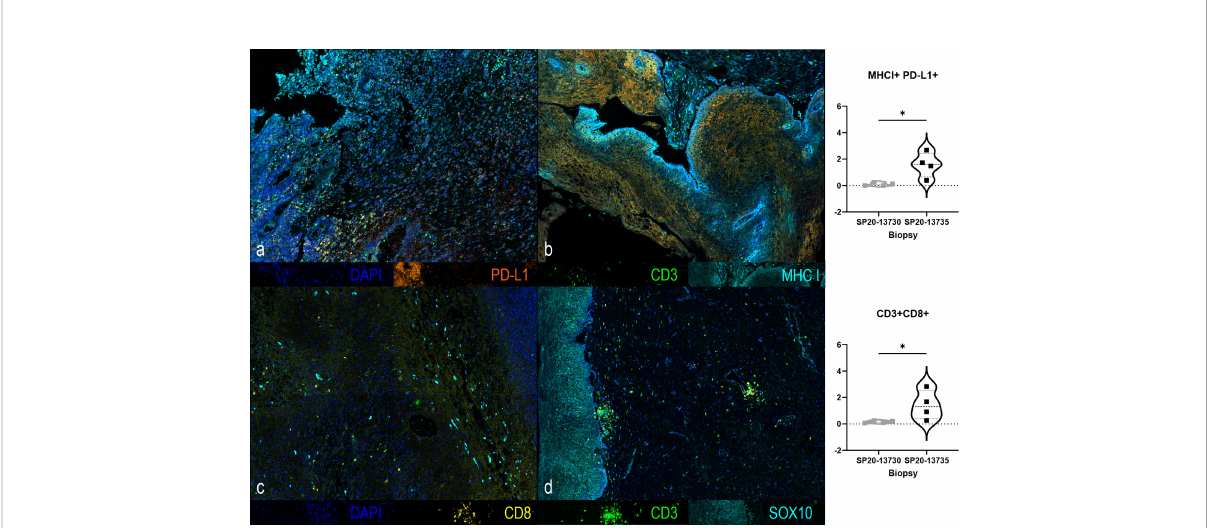
FIGURE 3 Multiplex immuno fl uorescence immunohistochemistry of tumor biopsies at baseline (A, C) and at 3 months (B, D) following the initiation of ipilimumab and nivolumab showing changes in CD3 (green), CD8 (yellow), PD-L1 (orange), MHCI (cyan), SOX10 (cyan) and DAPI (blue) immunostains. A signi fi cant increase in the expression of MHC-I+/PD-L1+ (p=0.0286, 2-Tailed Mann-Whitney) and of CD3+/CD8+ (p=0.0286, 2-Tailed Mann-Whitney) was found at 3 months compared to baseline. *, It designates a p value lower than 0.05.